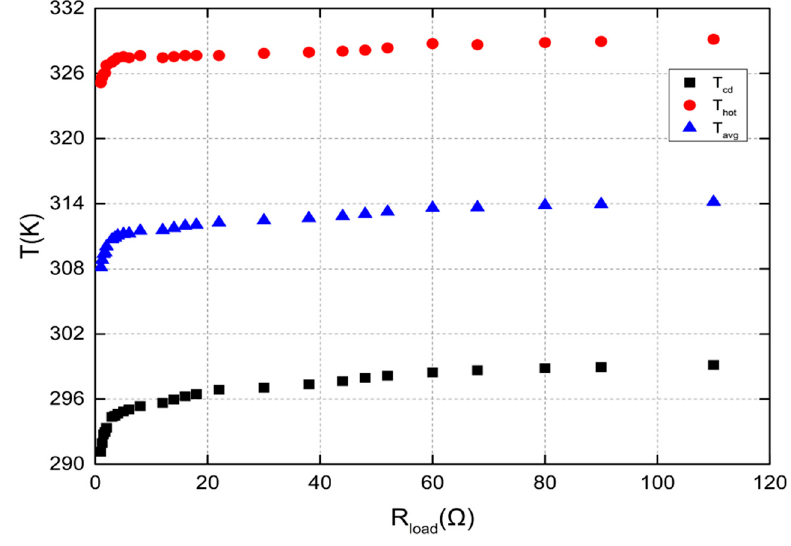
Figure 3. Change trends of T hot , T cd and T avg with the load resistance.